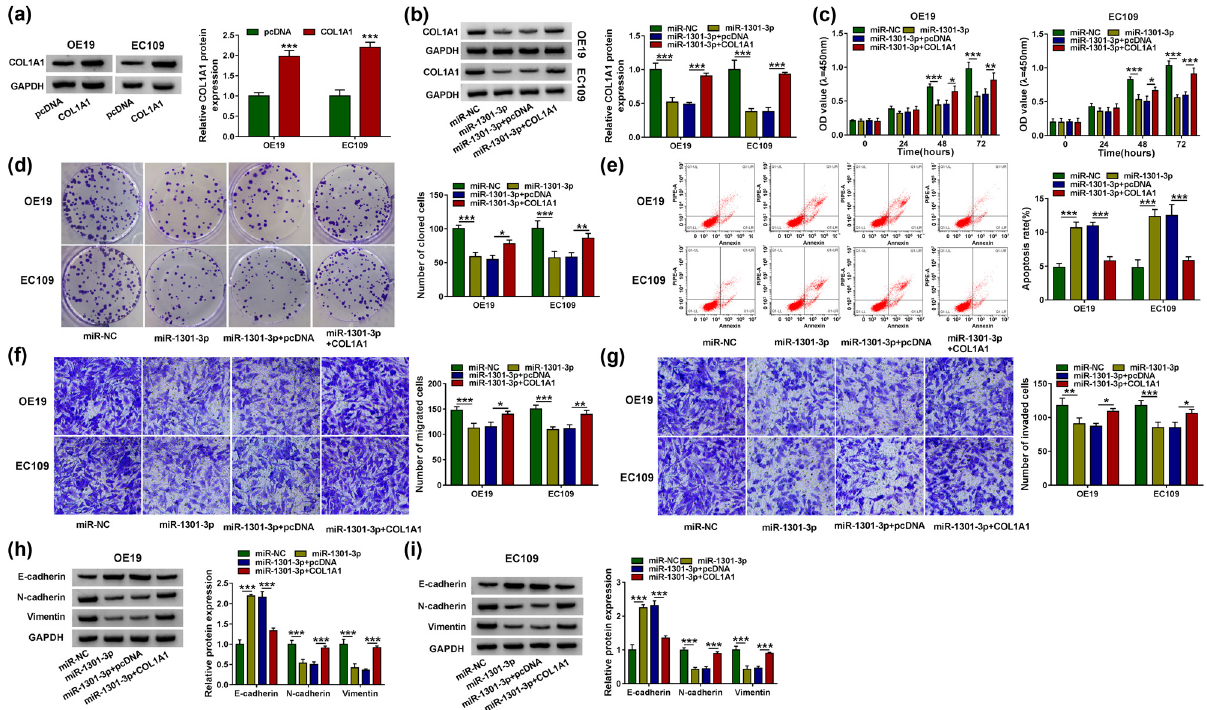
Figure 6: COL1A1 partially rescued the function of miR - 1301 - 3p. ( a ) The protein expression level of COL1A1 was measured by western blot analysis in OE19 and EC109 cells. ( b ) OE19 and EC109 cells were transfected with miR - NC, miR - 1301 - 3p, miR - 1301 - 3p + pcDNA, or miR - 1301 - 3p + COL1A1, individually. And relative COL1A1 protein level was detected by western blot analysis. ( c – e ) The cell proliferation, cloning, and apoptosis were analyzed by CCK - 8, colony formation assay, and fl ow cytometry. ( f and g ) The cell migration and invasion were measured by Transwell assay after transfecting with miR - NC, miR - 1301 - 3p, miR - 1301 - 3p + pcDNA, or miR - 1301 - 3p + COL1A1. ( h and i ) EMT marker proteins E - cadherin, N - cadherin, and Vimentin in OE19 and EC109 cells were detected by western blot analysis. * P < 0.05, ** P < 0.01, *** P <